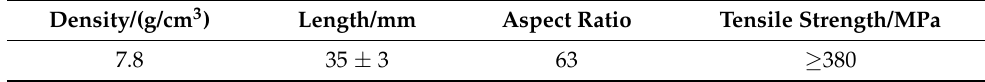
Table 3. Property parameters of steel fiber.